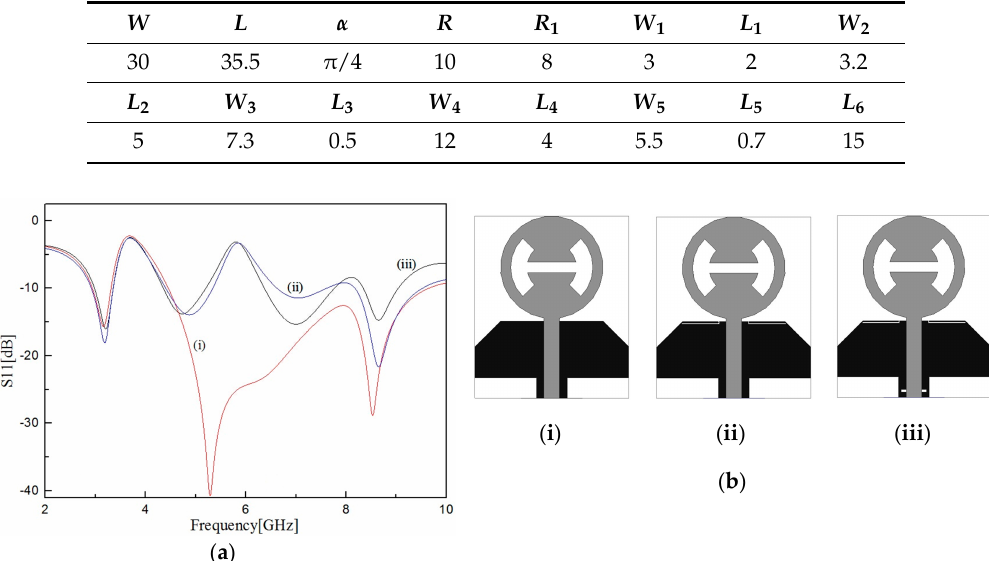
Figure 2. Stepwise evolution of the antenna and corresponding simulated return loss: ( a ) Simulated return loss against frequency for the various configurations; ( b ) structure evolution of antenna.